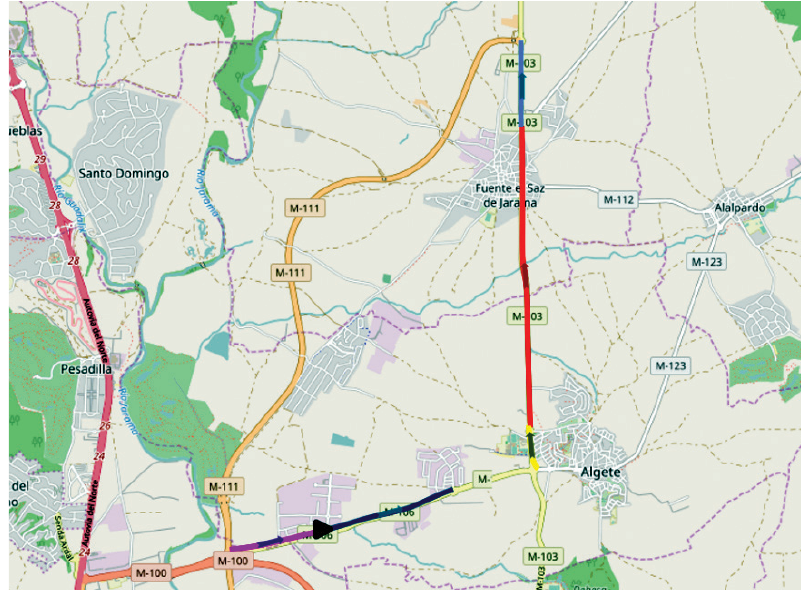
Figure 5. Test tracks analysed. Test Track 1 is marked dark blue, Test Track 2 – yellow, Test Track 3 – red, Test Track 4 – light blue, Test Track 5 – purple.